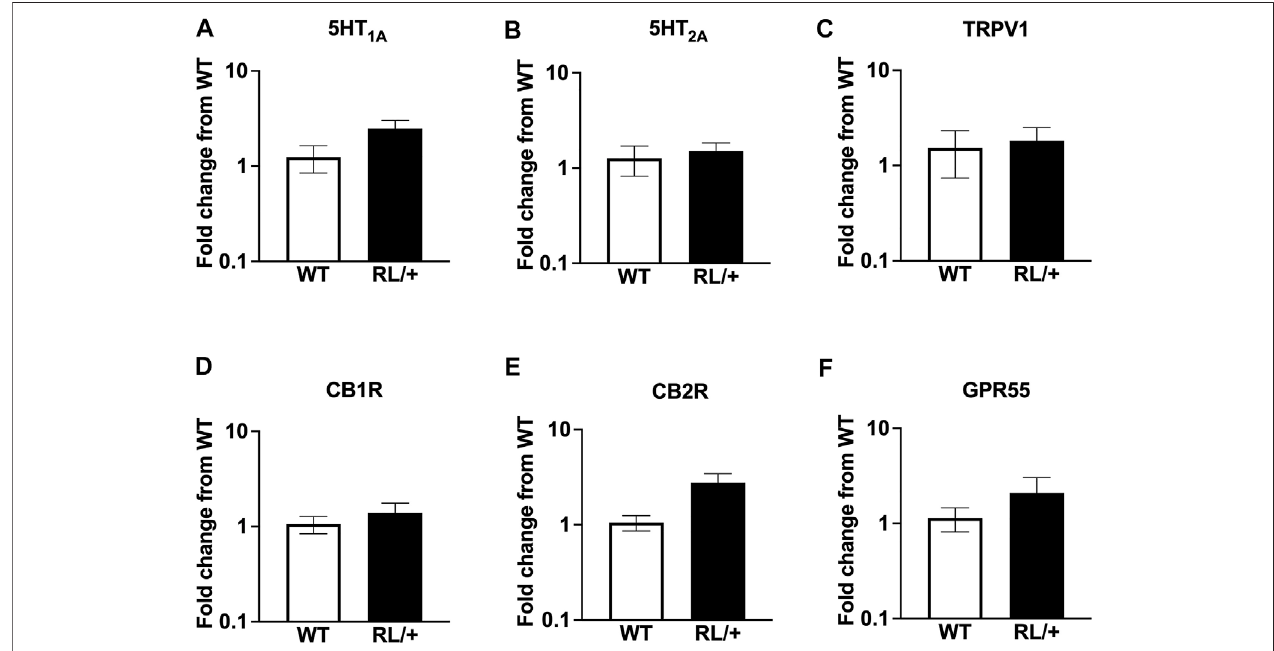
FIGURE3| RL/+mutantsandWTlittermateshavecomparableexpressionlevelsoftargetCBDreceptors: (A) 5HT 1A , (B) 5HT 2A , (C) TRPV1, (D) CB1R, (E) CB2R, and (F)